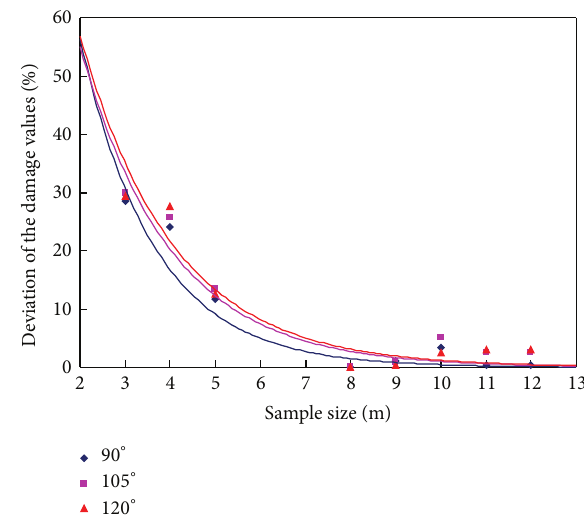
Figure 13: Deviation of the permeability values to that of 7 m sample under different directions of samples in different sizes.